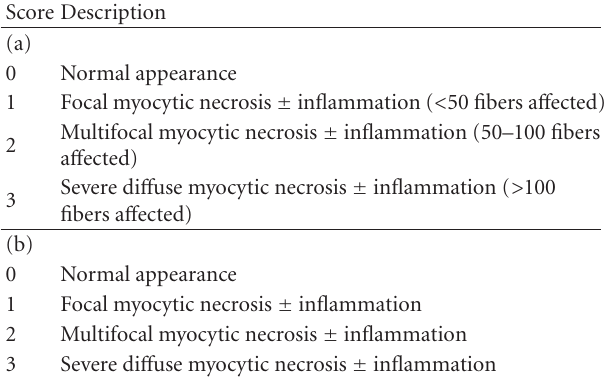
Table 1: Semiquantitative lesion scoring system adapted from McLoughlin et al. [34]. System covers heart and skeletal muscle lesions separately. Lesions starting from 0 (healthy tissue) to 3 (severe changes). (a) Heart lesion classification. (b) Skeletal muscle